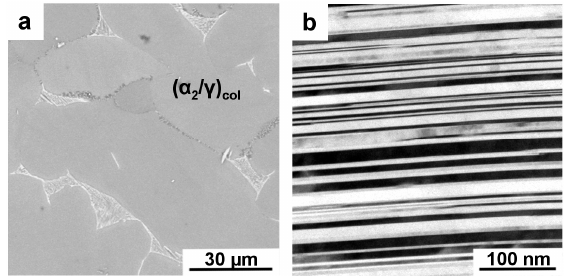
Figure 9. Microstructure after two-step heat-treatment taken by ( a ) SEM in BSE mode and ( b ) transmission electron miscroscopy (TEM) bright field image, as reported in reference [52]. Prior supersaturated α 2 grains have decomposed to α 2 / γ colonies, which cannot be resolved using SEM. Lamellae of each grain show only one orientation variant according to the Blackburn OR. Between lamellar colonies β o phase and several transformation products are visible (see text). The nano-